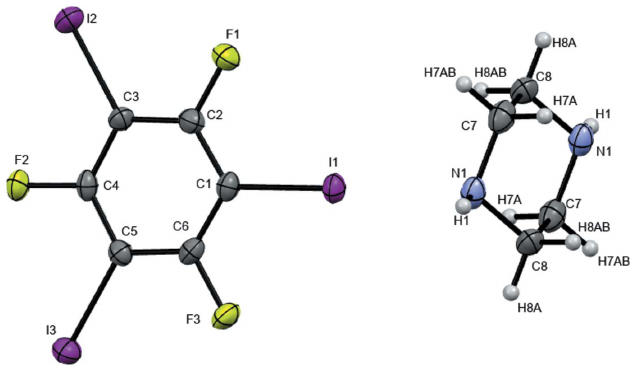
Figure 1 ORTEP plot of the title compound.